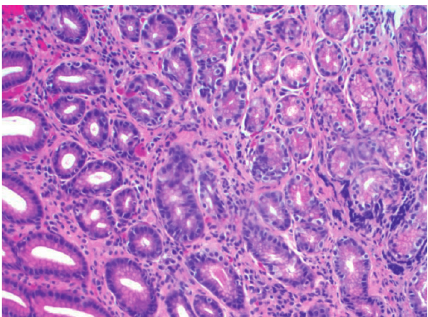
Figure 1: Gastric mucosa demonstrating chronic gastritis, intes- tinal metaplasia identified by Alcian blue-PAS stain, and absence of oxyntic glandular tissue, consistent with metaplastic atrophic gastritis. No dysplasia identified. No Helicobacter pylori identified by Giemsa stain.